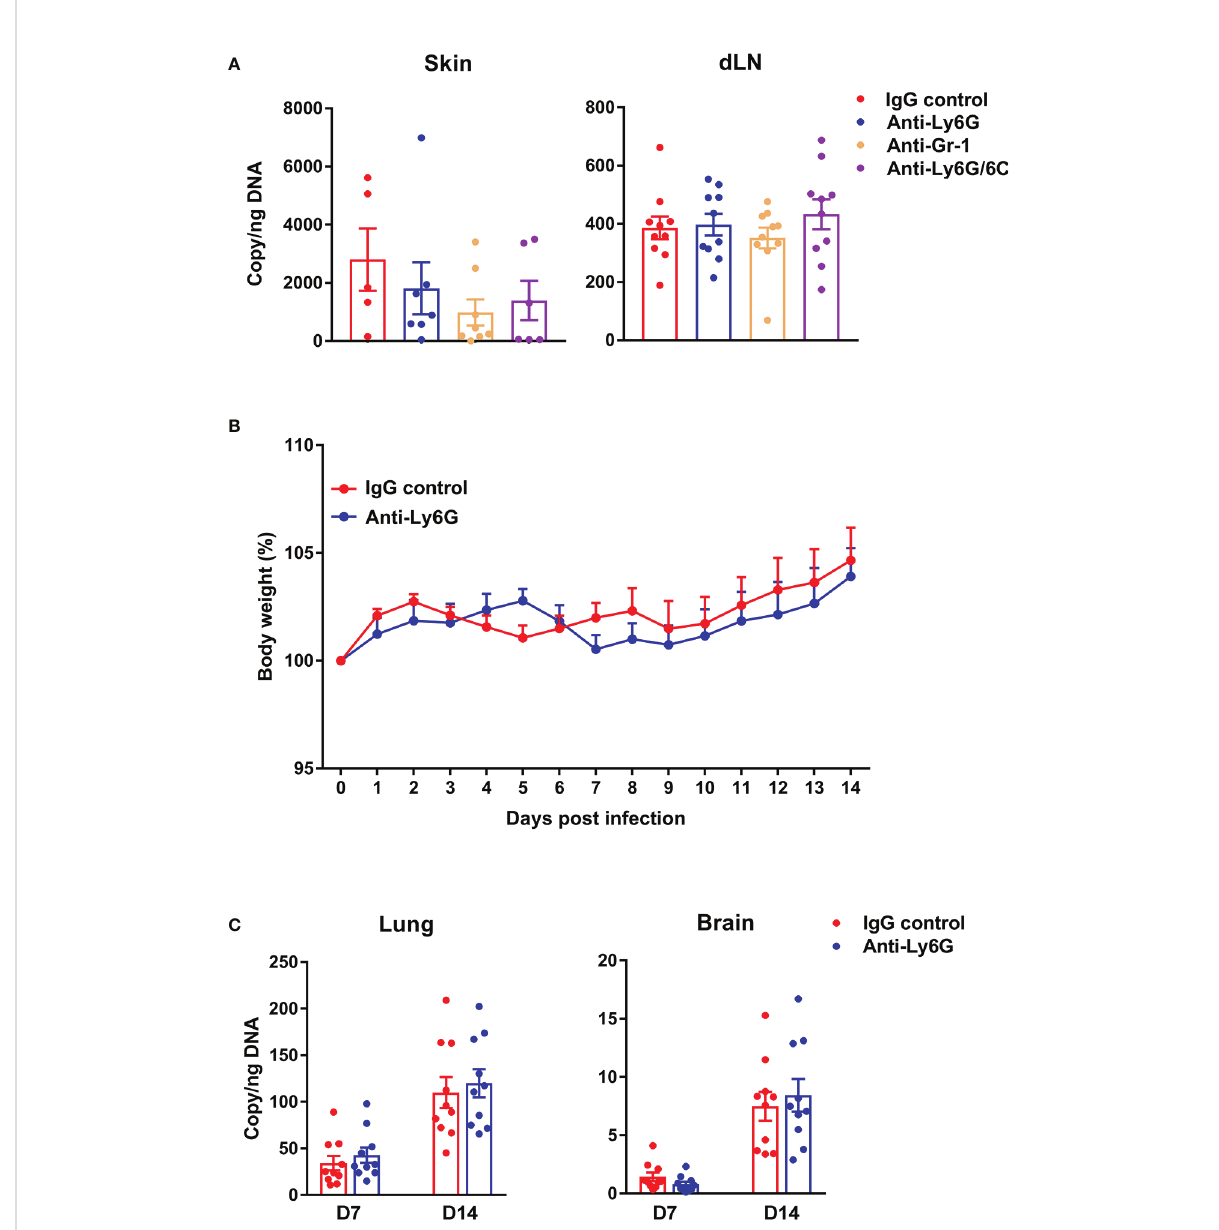
FIGURE 3 Depletion of neutrophils did not impact bacterial load in central or peripheral tissues of Ot -infected mice. B6 mice (n=10/group) were i.p. injected with anti-Ly6G, anti-Gr-1 or anti-Ly6G/6C antibody (clone#1A8, RB6-8C5 and NIMP-R14, respectively; 250 µg/mouse) at day -1, 0, 1 and 2 post-infection. Control mice were treated with IgG (250 µg/mouse). At day 0, mice were i.d. infected with Ot (4×10 3 FFU) in the ears. (A) On day 3, skin tissue and draining lymph nodes (dLN) were collected for quanti fi cation of bacterial load. (B) Bodyweight following Ot infection. (C) Lung and brain tissues were collected at days 7 and 14 and bacterial load was quanti fi ed. Values are shown as mean ± SEM from single experiments and are representative of two independent experiments. A one-way ANOVA with a Tukey ’ s multiple comparisons test is used for statistical analysis. A two-tailed Student ’ s t-test was used for comparison of two groups. No signi fi cant difference was found in these